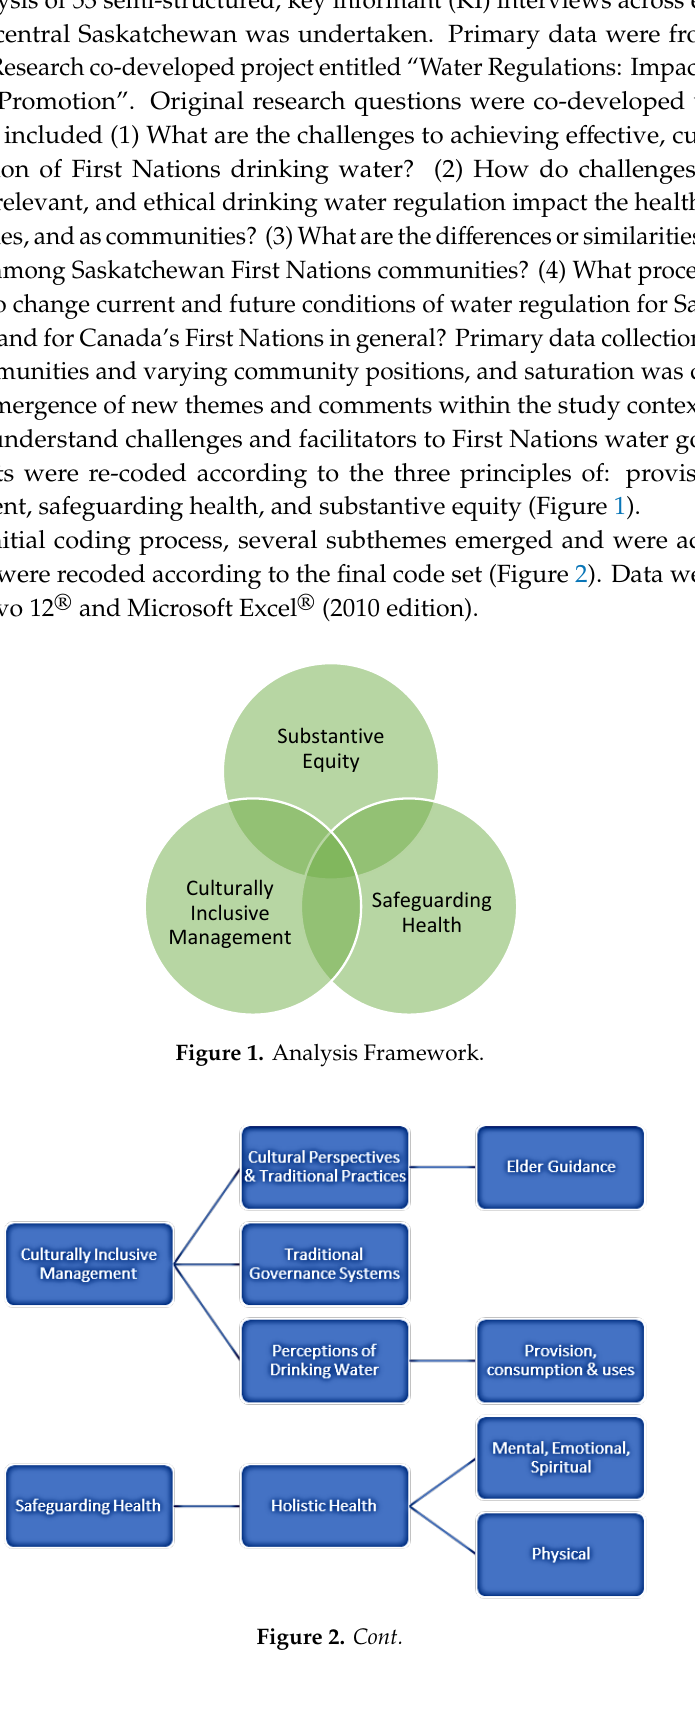
Figure 2. Final Code Set. 3. Results Of the 53 interviews, a maximum of 18 were from a single community and 18 were women participants (Table 1). KIs held a number of roles in the community, including community-based water treatment operators (3), water treatment officers (4), water treatment monitor (1), executive officer (1), Band Council member (1), documentation officer (1), community coordinator (1), public works supervisor/manager (2), community health worker (3) and community management team member (1). The largest proportion of perspectives were from community Elders (35). Results are presented within the overarching principles of culturally inclusive management, safeguarding health, and substantive equity.